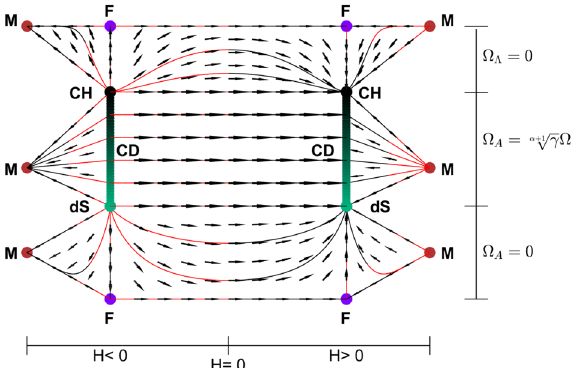
1 and γ < 2 3 . Here, dots denote the = 1, � � 0, � A 0, k 0 ) , = = = = 0, � � 0, � A 0, k 1 ) , de Sitter solution (� 0, � � 1, � A 0, k 0 ) , = = = = − = = = = 1, � � 0, � A 0 ) and Chaplygin-de Sitter solution line 1 √ γ , k α + = = = =